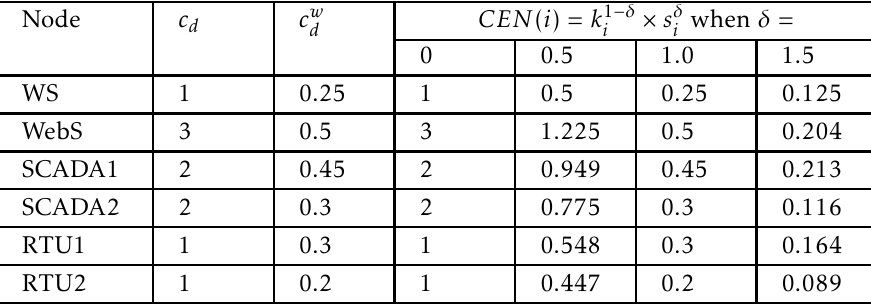
Table 3. Degree centrality at different δ .